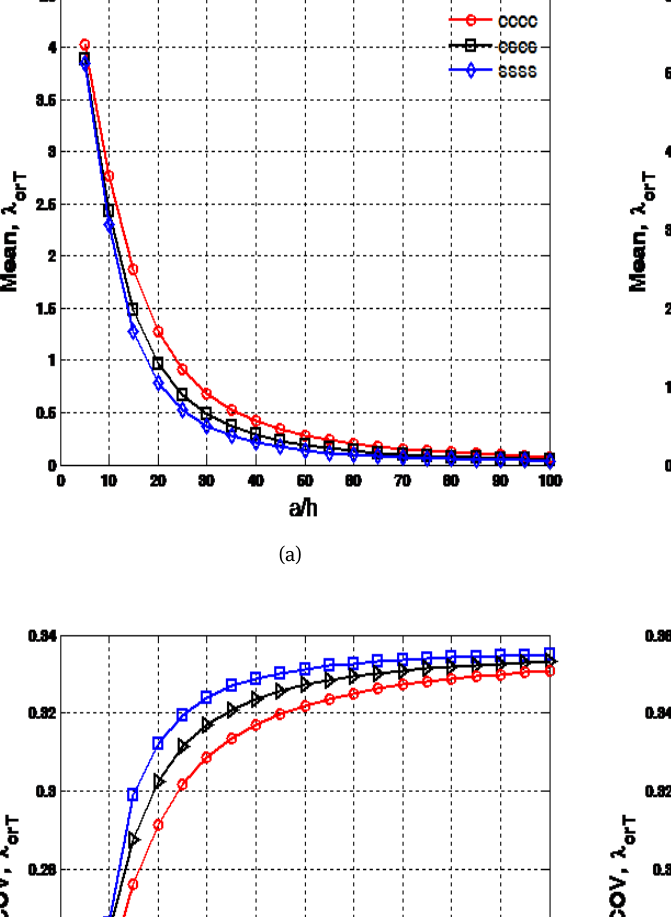
Figure 6: The effect of cross-ply and angle-ply symmetric and anti symmetric lamination scheme and plate thickness ratios with ran- dom change in all system parameres on the (a) mean and ( b ) COV of buckling